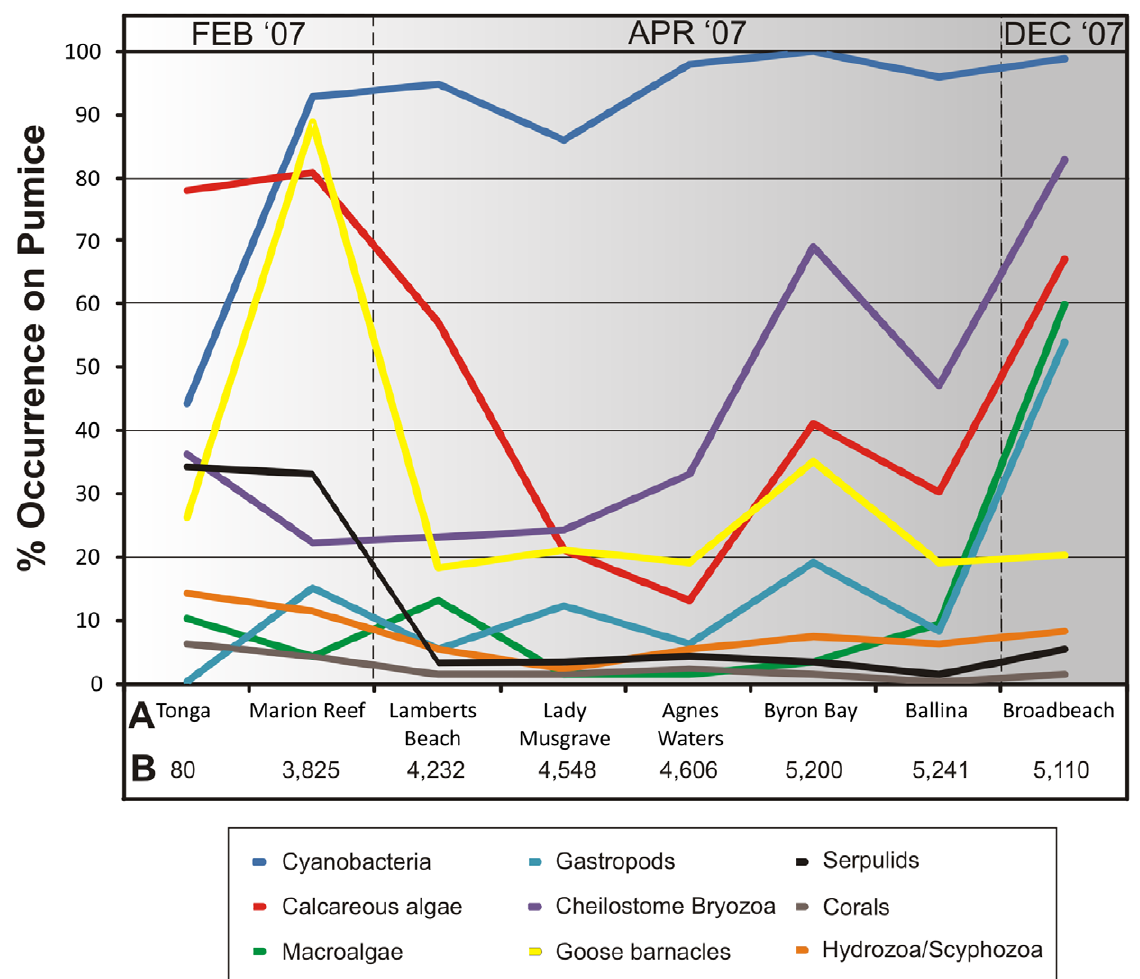
Figure 6. Biotic changes of the Home Reef pumice rafts during 2006 and 2007. Frequency of occurrence (expressed as %) of biota on pumice clasts is shown relative to pumice raft arrival time, sample location (A) and approximate distance along the trajectory in kilometres (B), which correlates with floating time. Three general epibiont trends are observed with time: 1) rapid colonisation of all available pumice resulting in ubiquity (cyanobacteria) – a few sample sites showed slightly reduced occurrences of cyanobacteria on pumice (e.g., Lady Musgrave), but this resulted from clast abrasion across reefs, followed by some post-stranding desiccation and spalling; 2) a progressive increase in occurrence with time (e.g., cheilostome Bryozoa, gastropods and macroalgae) and; 3) stalled colonisation where some species were successfully recruited early on to pumice but underwent no further colonisation expansion due to insufficient time to reach sexual maturity (corals), or the epibionts continued to colonise the same clast (serpulids, hydrozoans/scyphozoans), increasing the numbers of conspecifics per clast; these taxa also had relatively low initial